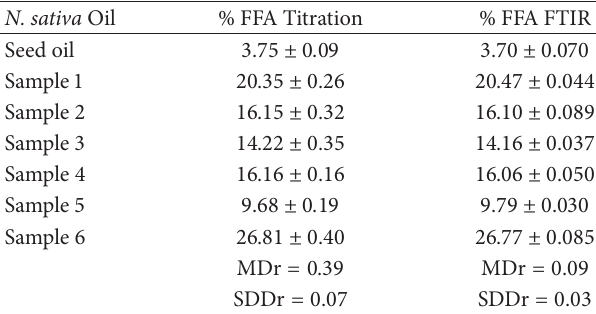
Table2:FFAcontent(Mean ± SD)ofcommercialand N.sativa seed oil by Titrimetric and SB-ATR FTIR